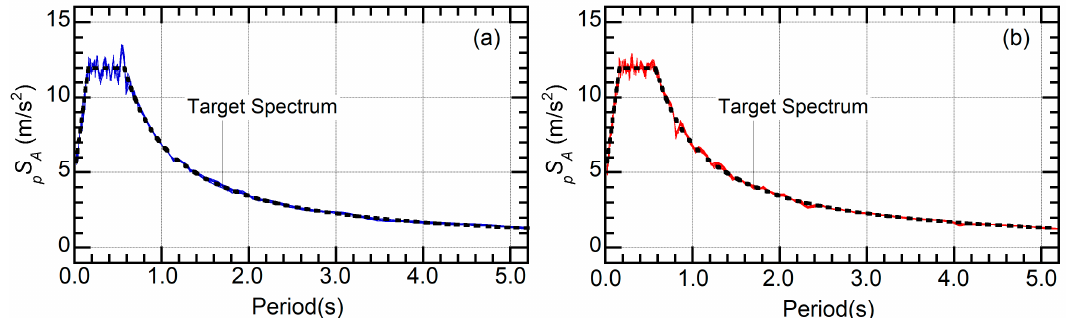
Figure 7. Elastic pseudo-acceleration target spectra of the generated artificial ground motions: ( a ) Art-S Series; ( b ) Art-L Series.